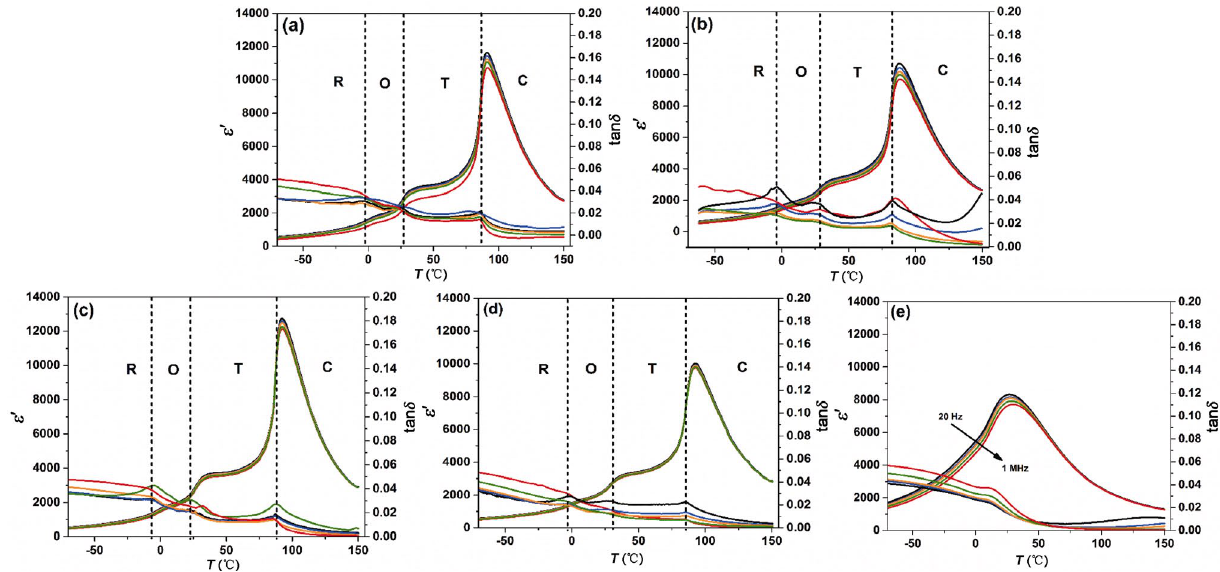
Fig. 5 Temperature-dependent real part of the dielectric permittivity and tan δ in the frequency range of 20 Hz − 1 MHz, for samples sintered at 1350 ℃ , with (a) 0, (b) 0.025, (c) 0.05, (d) 0.25, and (e) 2.5 mol%